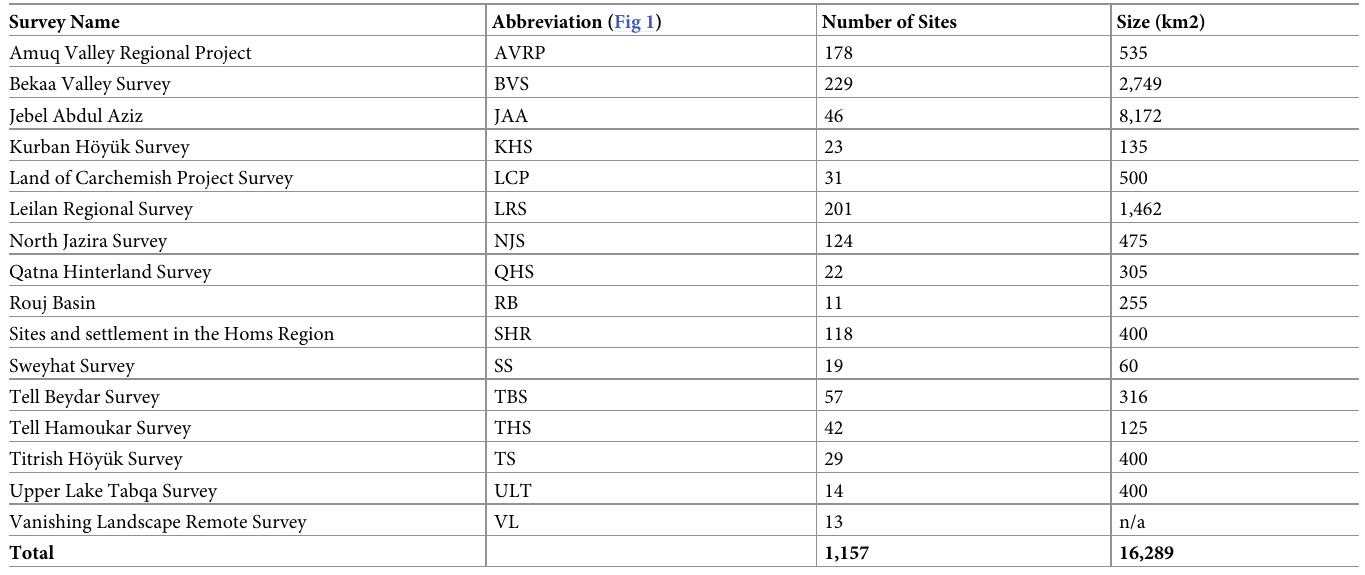
Table 1. Surveys used for site count